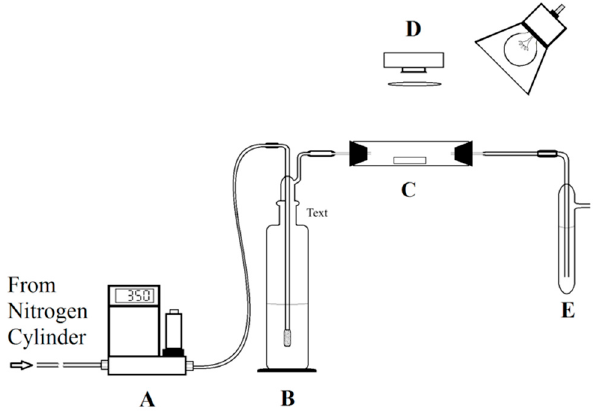
Figure 2. A schematic diagram of the apparatus depicting the ( A ) flow controller, ( B ) bubbler to entrain peroxide vapor, ( C ) exposure chamber, ( D ) detection system, and ( E ) a bubbler used to determine the total concentration of peroxide in the flow.